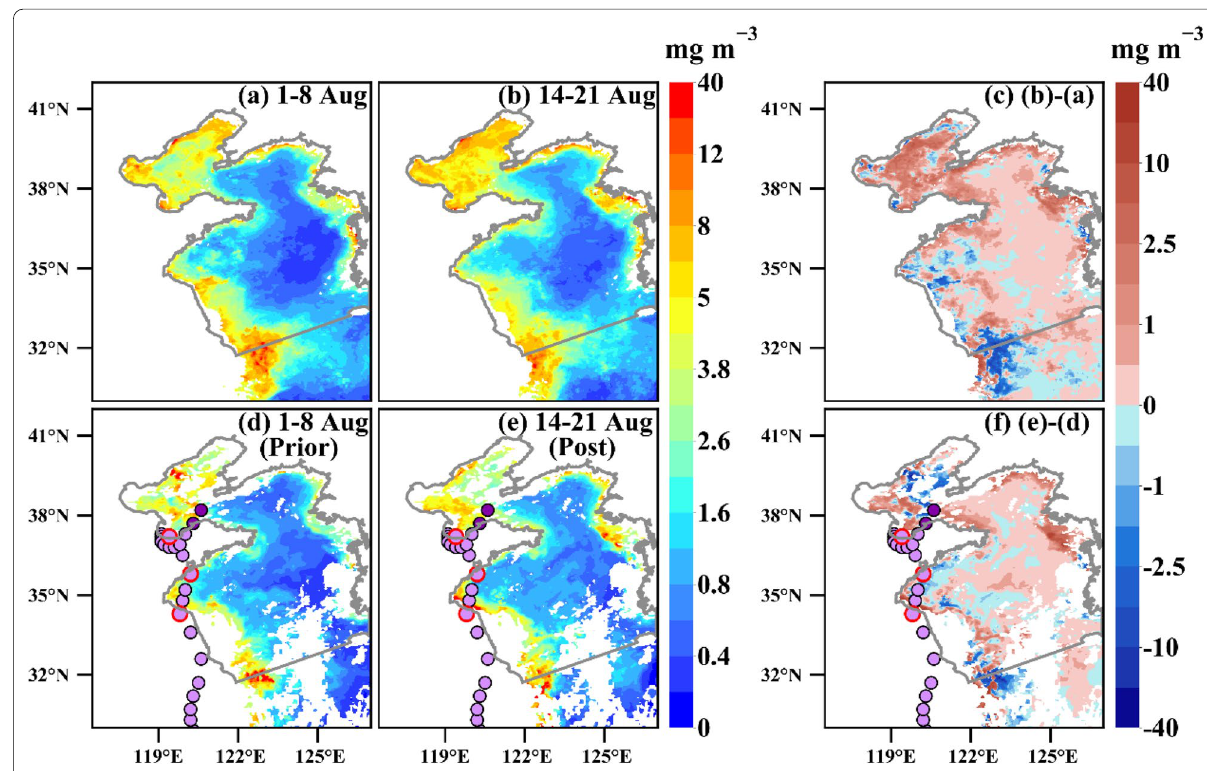
Fig. 4 Chlorophyll‑a (Chl‑a) during 1–8th August ( a , d ) and 14–21st August ( b , e ), and the difference ( c , f ) between the two periods for non‑typhoon years (top panel) and 2019 (lower panel) in the Yellow‑Bohai Sea